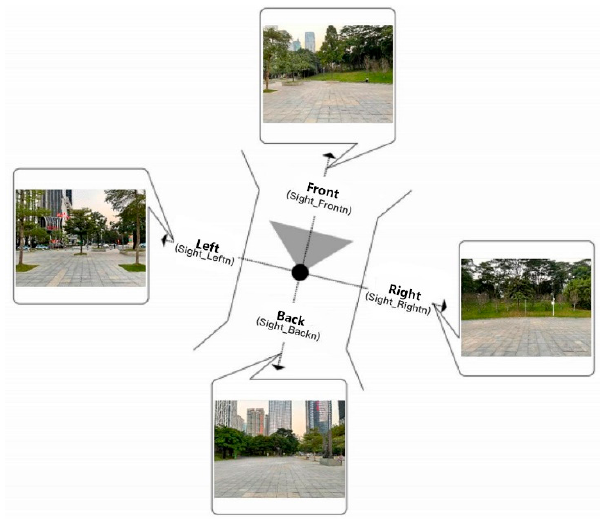
Figure 3. Collection of images at Sight_Frontn, Sight_Rightn, Sight_Leftn, and Sight_Backn according to the user’s direction of travel.